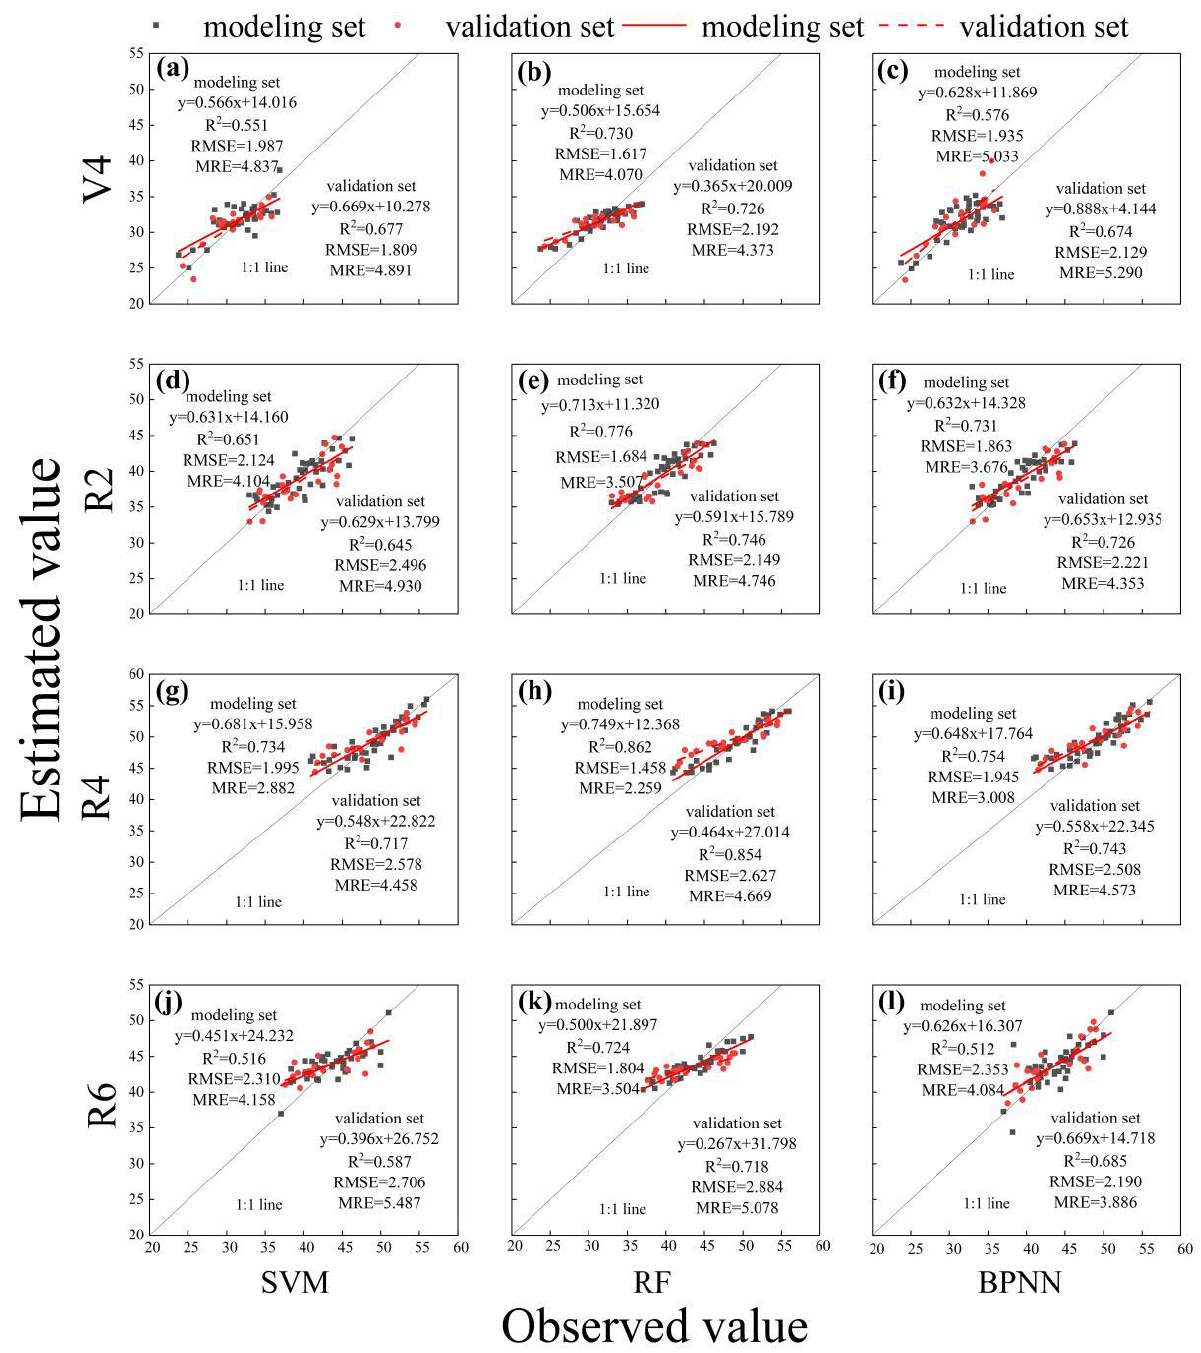
Figure 7. Model evaluation results, ( a – c ) is the prediction model of soybean chlorophyll content in the V4 growth period constructed by SVM, RF, and BPNN methods; ( d – f ) is the result of the R2 growth period soybean chlorophyll content prediction model created by SVM, RF, and BPNN; ( g – i ) is the result of R4 growth period soybean chlorophyll content prediction model constructed by SVM, RF, and BPNN; ( j – l ) is the result of R6 growth period soybean chlorophyll content prediction model produced by SVM, RF, and BPNN